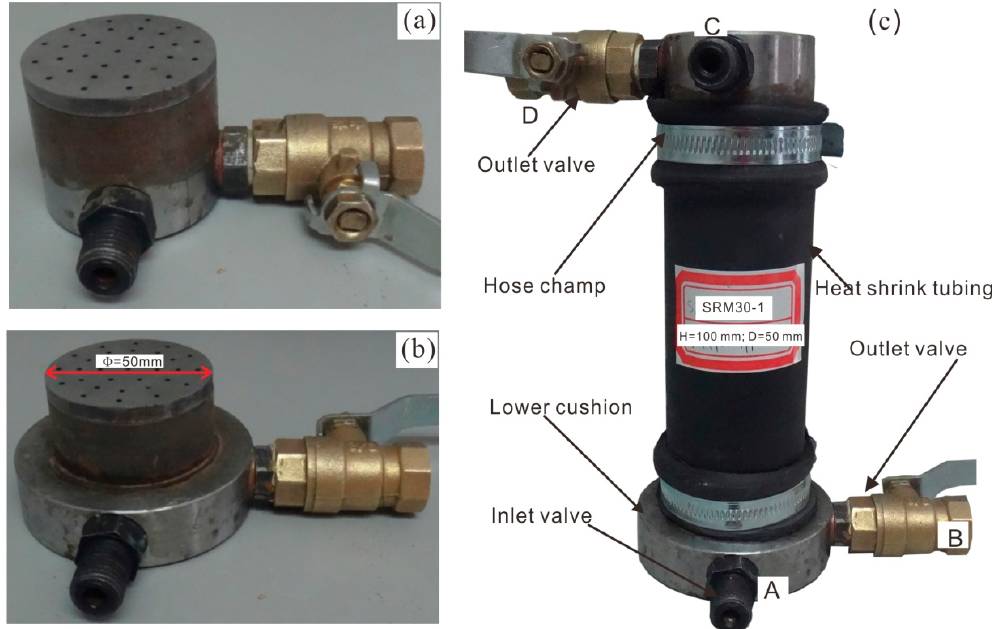
Figure 2. Photograph of the sample chamber structure and metal permeability cushions [5]: ( a ) the upper cushion; ( b ) the lower cushion; and ( c ) structure of the sample chamber.